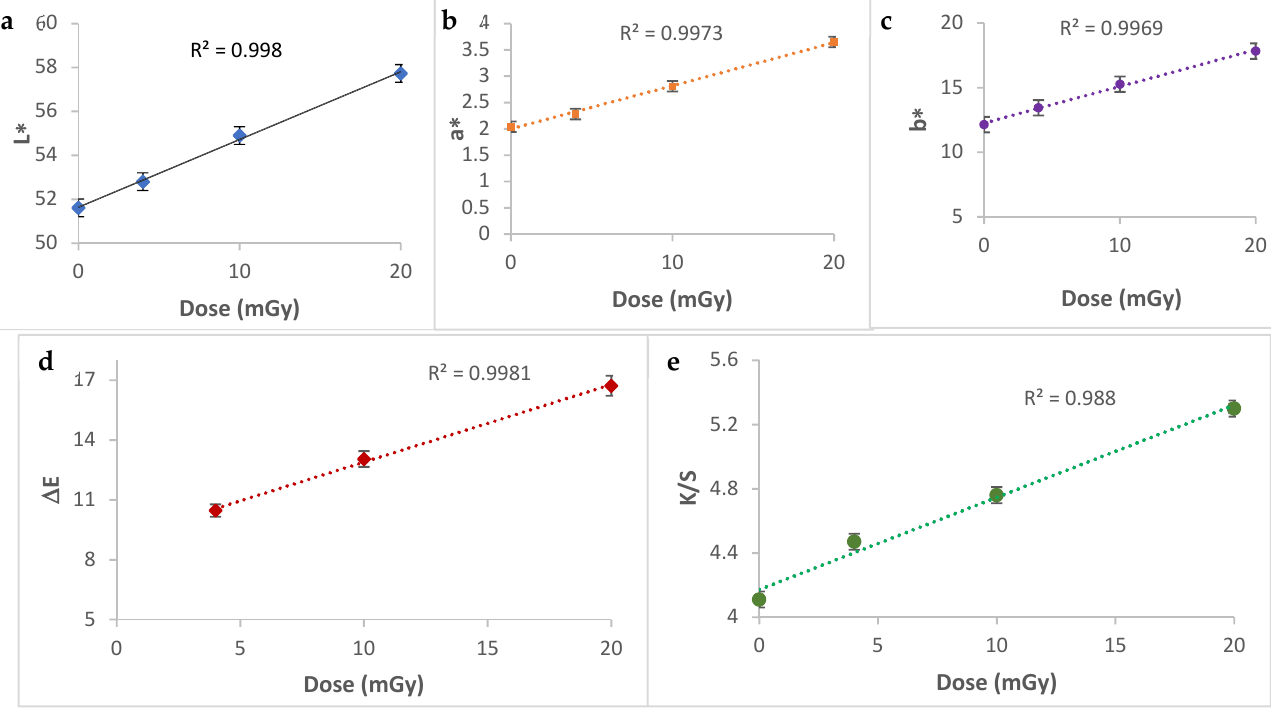
Figure 8. CIELab color parameters (L*, a* and b*) ( a – c ), total color difference ( ∆ E) ( d ) and color strength (K/S) ( e ) measurements for PVA/Ag + /NBT films irradiated from 4 to 20 mGy.